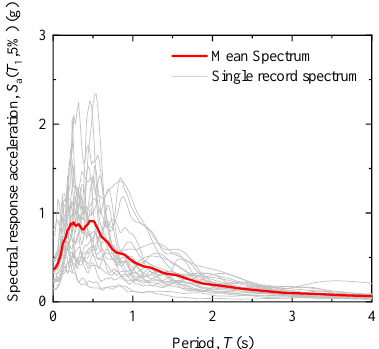
Figure 14. Acceleration spectra of ground motions.